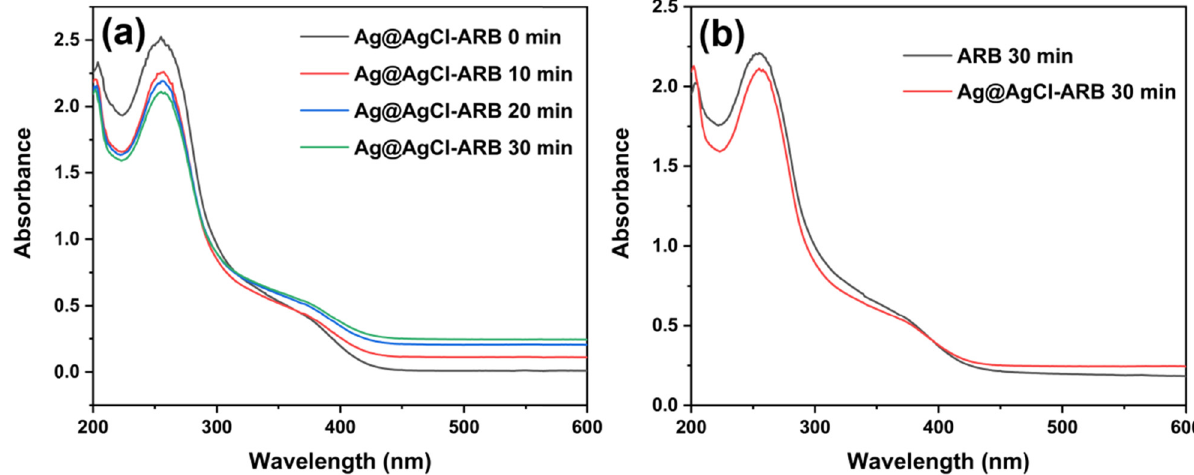
Figure 11: The NBT absorbance curves of Ag@AgCl – ARB with increasing time ( a ) and the comparison of ARB and Ag@AgCl – ARB ( b )